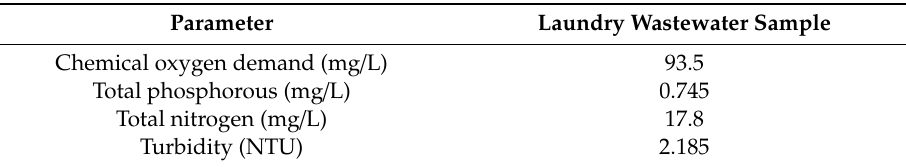
Table 1. Characteristics of the laundry wastewater sample.